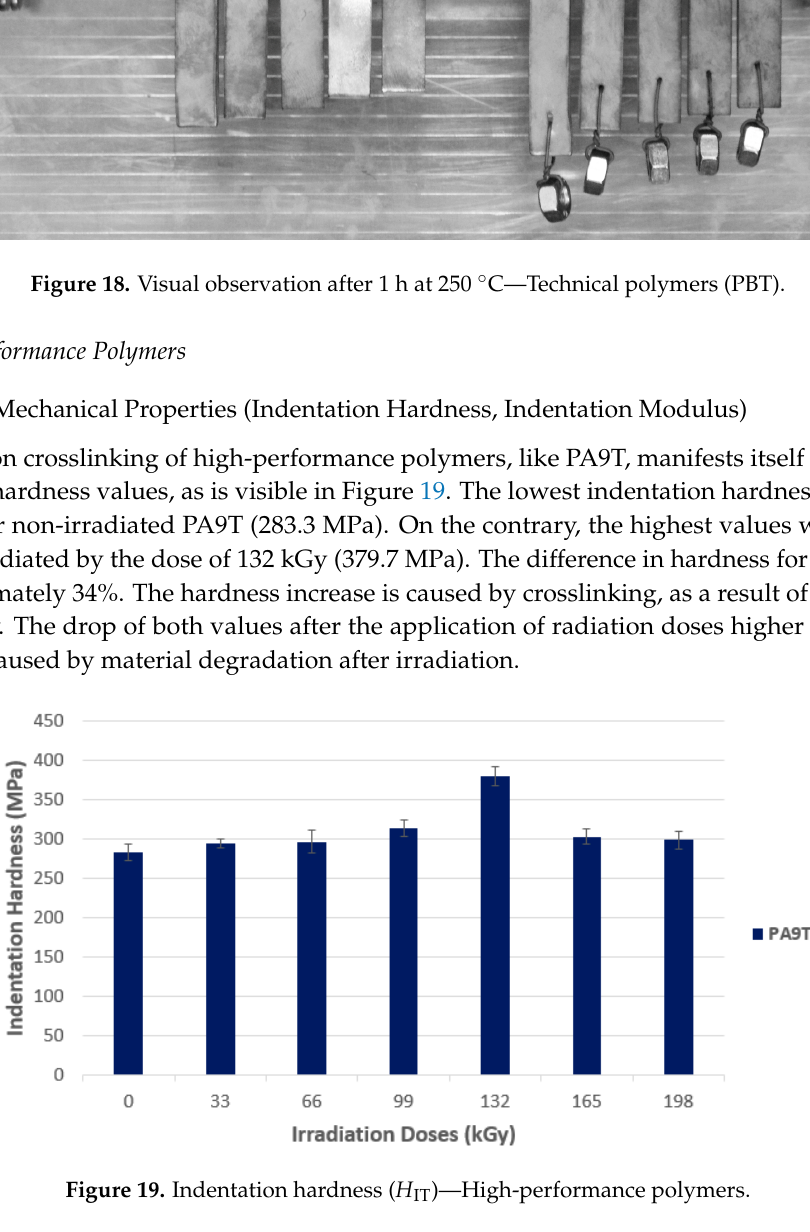
Figure 20. Indentation modulus ( E IT )—High-performance polymers. As is apparent from the results of the measurement of indentation hardness and indentation modulus, during which essential changes of the mechanical properties of the selected material types occur due to the application of different beta radiation doses. Thanks to the differentiated application of radiation doses, improvements in the usual material properties occur; thereby, cheaper commodities or technical materials can replace more expensive technical or high-performance